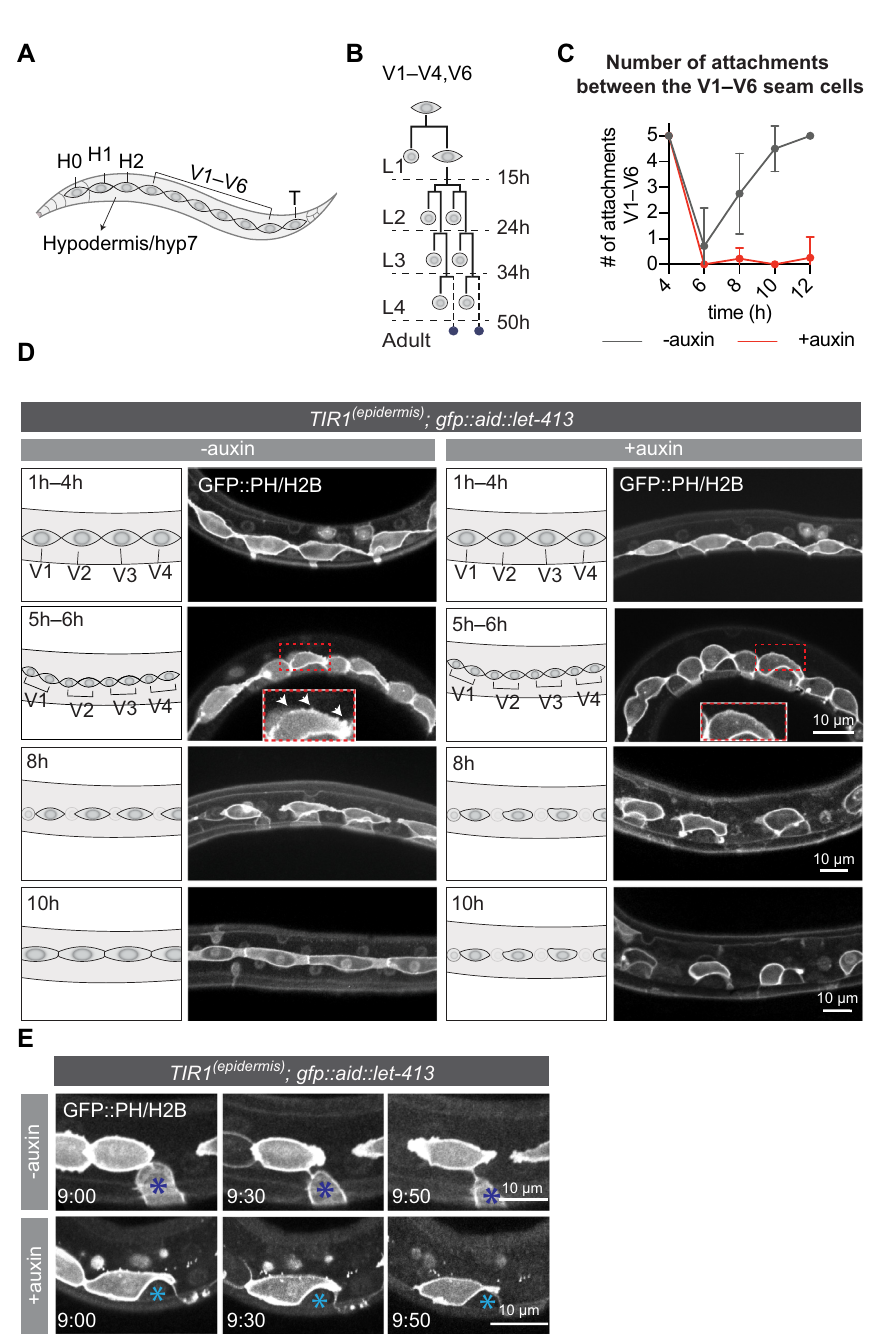
Fig 3. Loss of LET-413 leads to failure in seam cell outgrowth and reattachment after the asymmetric divisions. ( A ) Schematic representation of the C . elegans epidermis (lateral view). ( B ) Division pattern of the V1–V4 and V6 seam cells. Dotted lines demarcate the larval stages. Asymmetric divisions generate one differentiating daughter cell (round anterior cell) and one seam cell. During the L4 to adult molt, the remaining seam cells fuse and form a syncytium (small blue cells). ( C ) Number of attachments between the V1–V6 seam cells in LET-413-depleted (+auxin) or control animals (-auxin) (strain BOX582). Solid lines represent mean ± SD. N = 7, 7, 16, 16, and 11 for -auxin time points, and 7, 9, 15, 15, and 13 for +auxin time points. Genotype is Pwrt-2 :: TIR1 :: BFP; GFP :: AID :: let-413; heIs63 [Pwrt- 2 :: GFP :: PH; Pwrt-2 :: GFP :: H2B; Plin-48 :: mCherry] . Time indicates hours post hatching. ( D ) Time series of L1 seam cell divisions and subsequent extension in LET-413-depleted (+auxin) or control animals (-auxin) (strain BOX582). Seam- specific GFP::H2B and GFP::PH mark DNA and cell membrane, respectively. Images are single apical focal planes. Times indicate hours post hatching. White arrows at 5–6 h time point indicate membrane protrusions. ( E ) P